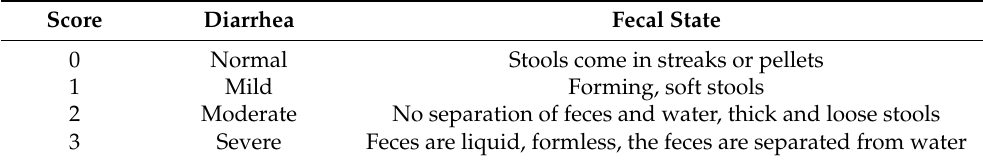
Table 2. Diarrhea scoring